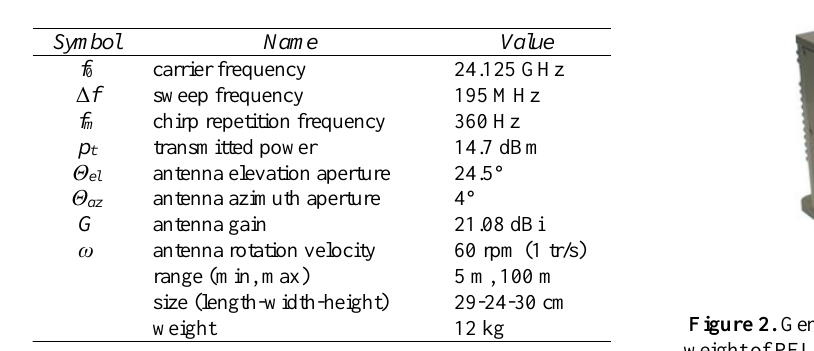
Table 1. PELICAN radar characteristics.